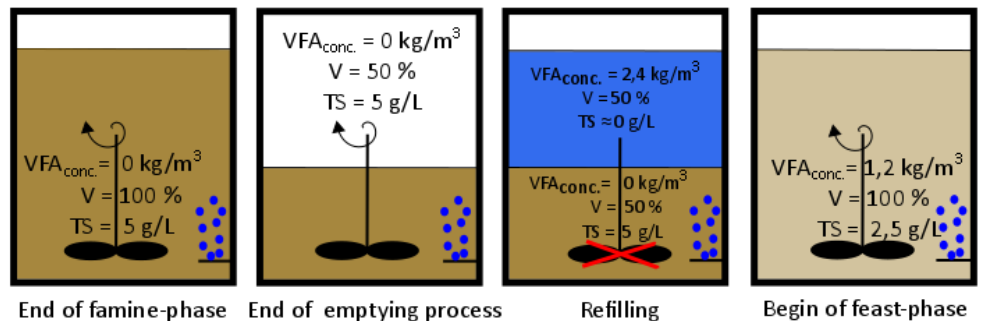
Figure 3. Emptying and refilling process during aerobic dynamic feeding (values shown are an example for investigated operation conditions), modified after [28].